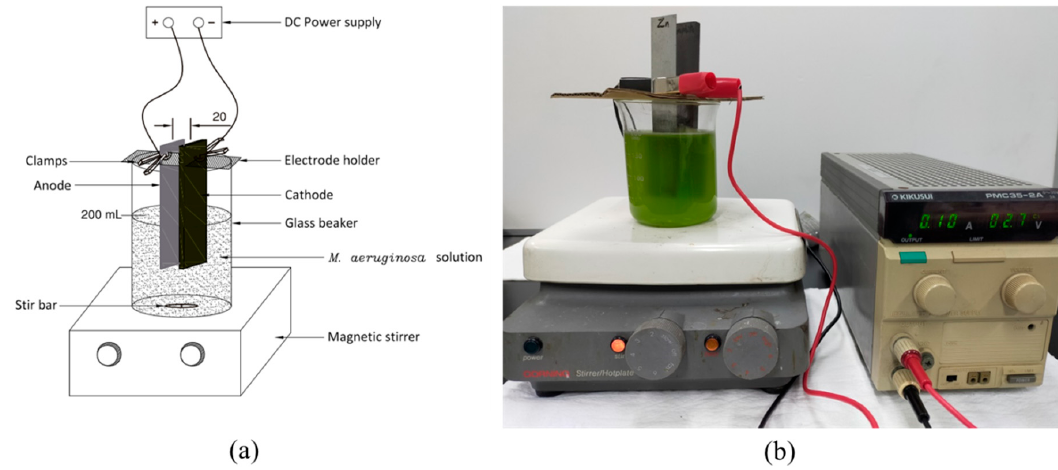
Figure 2. ECF experimental setup for M. aeruginosa treatment. ( a ) Schematic experimental setup (scale 1:10, dimensions are presented in mm). ( b ) Actual experimental setup. The experiments were conducted in 200 mL glass beakers. The electrodes were connected to a DC power supply (PMC35-2A, KIKUSUI, Kanagawa, Japan) and M. aeruginosa suspensions were stirred at 200 rpm using a magnetic stirrer (PC-320, CORNING, Corning, NY, USA). Table 3. Details of different electrodes used for ECF process.